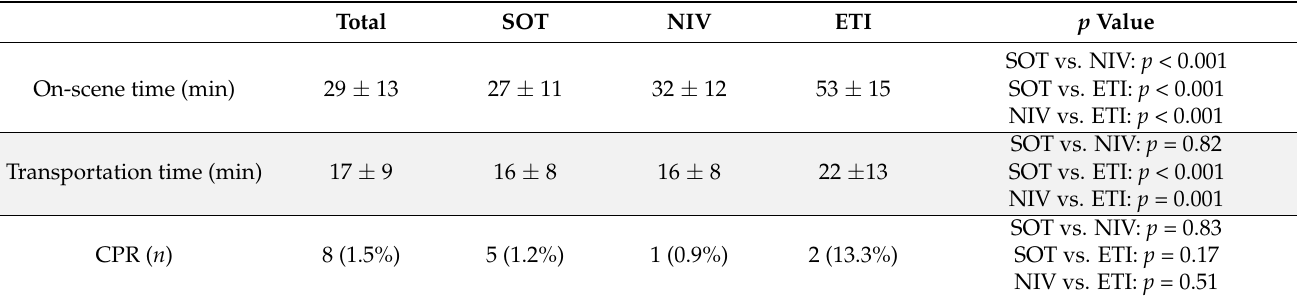
Table 3. Time consumption and cardiac